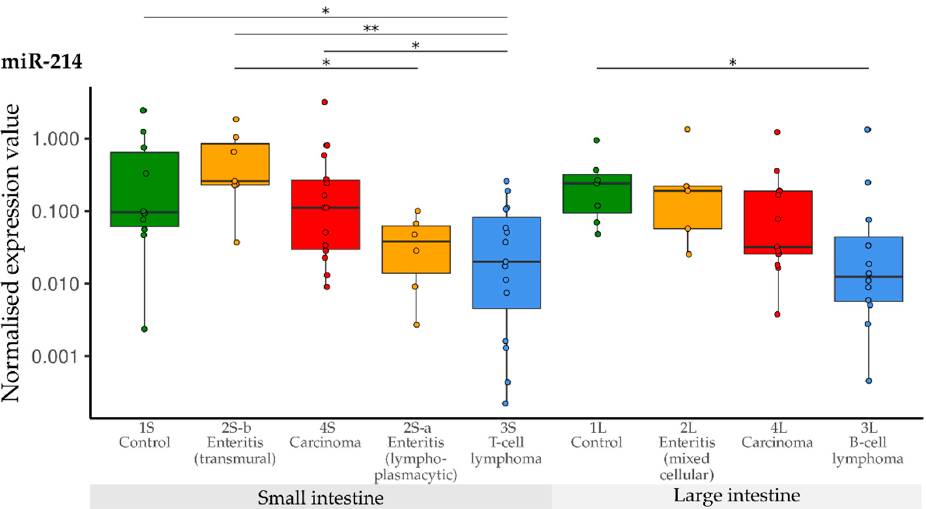
Figure 10. Expression levels of miR-214 in different groups (control, enteritis, carcinomas, lymphomas of the small and large intestine). The absolute miRNA copy number was related to the internal normaliser RNU6B. Results are shown as normalised expression values with a log10 scale. * p < 0.05, ** p < 0.005. Green control group, yellow enteritis, red carcinoma, blue